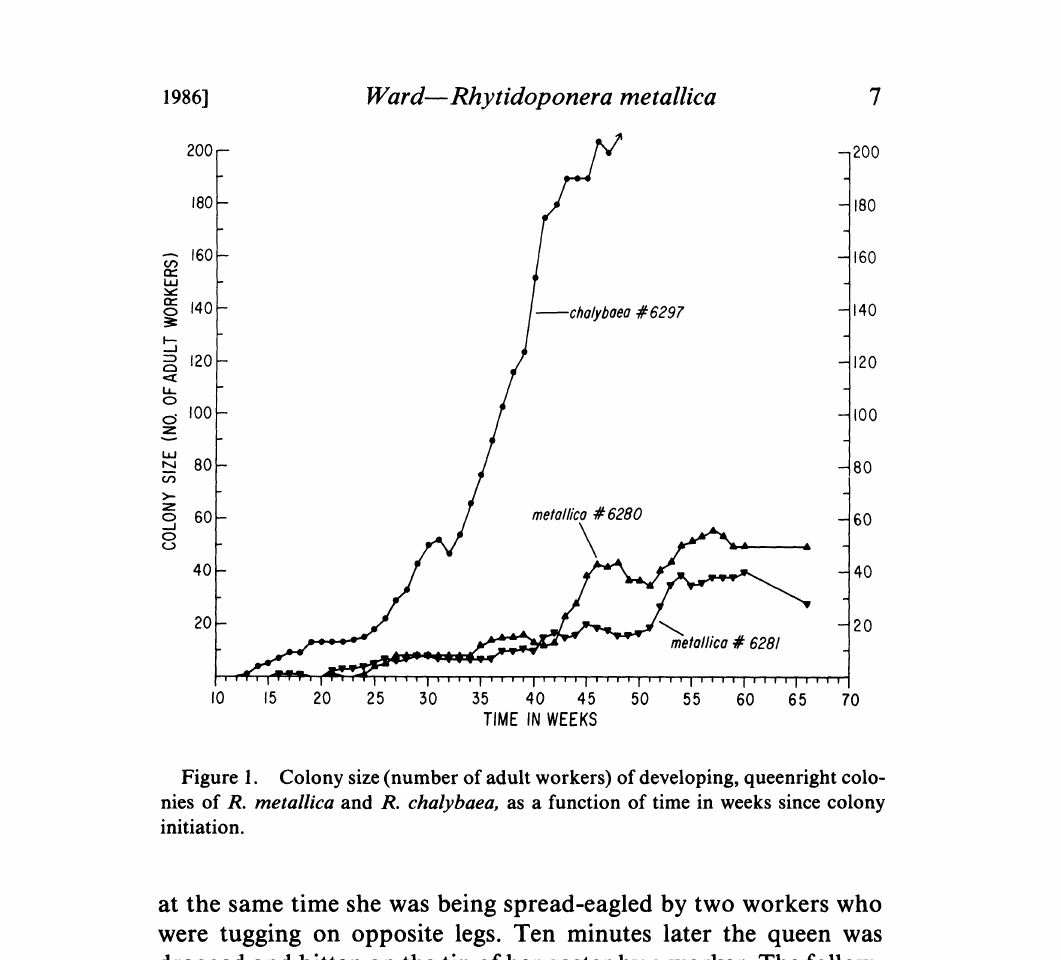
Figure 1. Colony size (number of adult workers) of developing, queenright colo- nies of R. metallica and R. chalybaea, as a function of time in weeks since colony